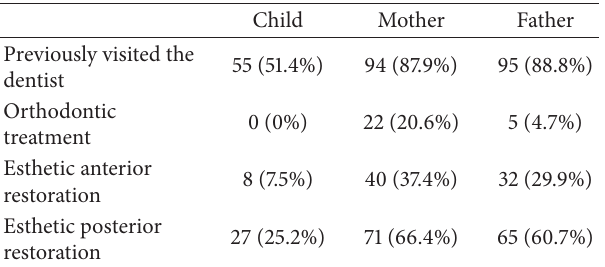
Table 2: Past dental experience of the population.